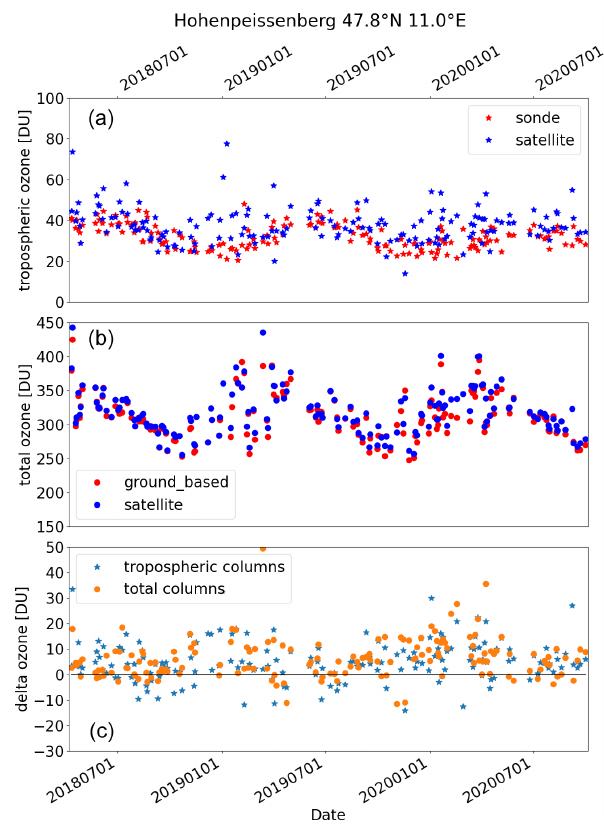
Figure 9. Comparison of S5P-BASCOE tropospheric ozone columns with ozonesondes at Hohenpeißenberg. In panel (a) the tropospheric columns are compared to the integrated sonde mea- surements. In panel (b) the total ozone columns are compared. In panel (c) the differences between the satellite data and the integrated sondes data are